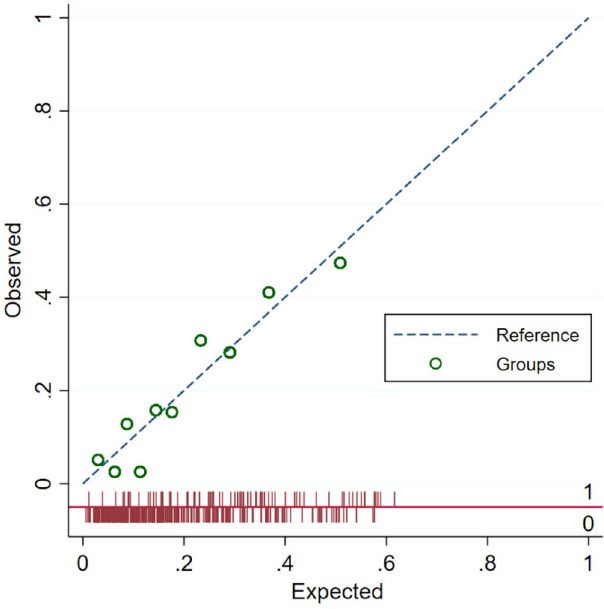
Figure 2. Calibration plot of multi-variable logistic regression model. Model diagnostics to determine how well the model fits the data. Perfect alignment along the dotted line indicates perfect correlation between predicted and observed outcomes.